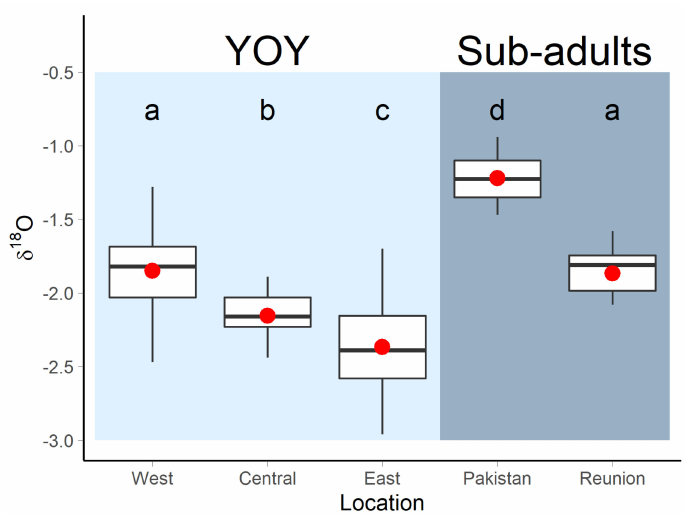
Figure 2. Boxplots showing otolith early life δ 18 O composition of YOY (light blue) and sub-adult (dark blue) yellowfin tuna ( Thunnus albacares ) from the Indian Ocean. Letters identify significant differences (Tukey HSD, p < 0.05) between location means. Inter quartile range (25th and 75th percentile) is shown by extent of boxes and error bars represent 10th and 90th percentiles. Median (50th percentile) and mean values are shown in boxes as black lines and red dots,